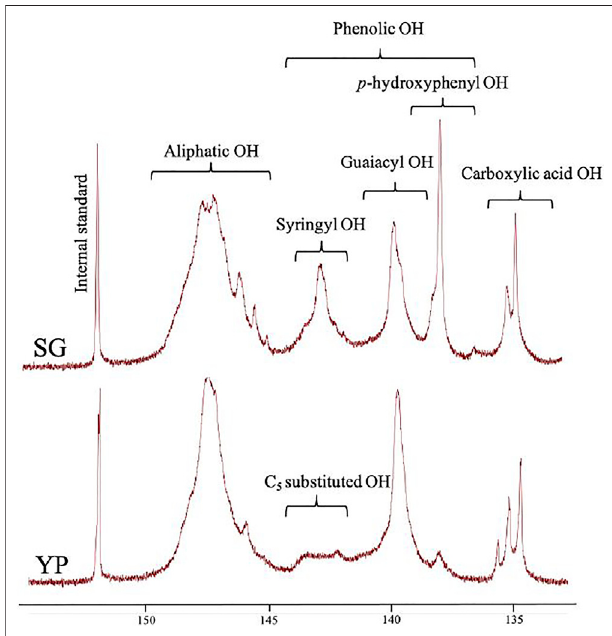
FIGURE 2 | Quantitative 31 P NMR spectra of SG and YP lignin samples.